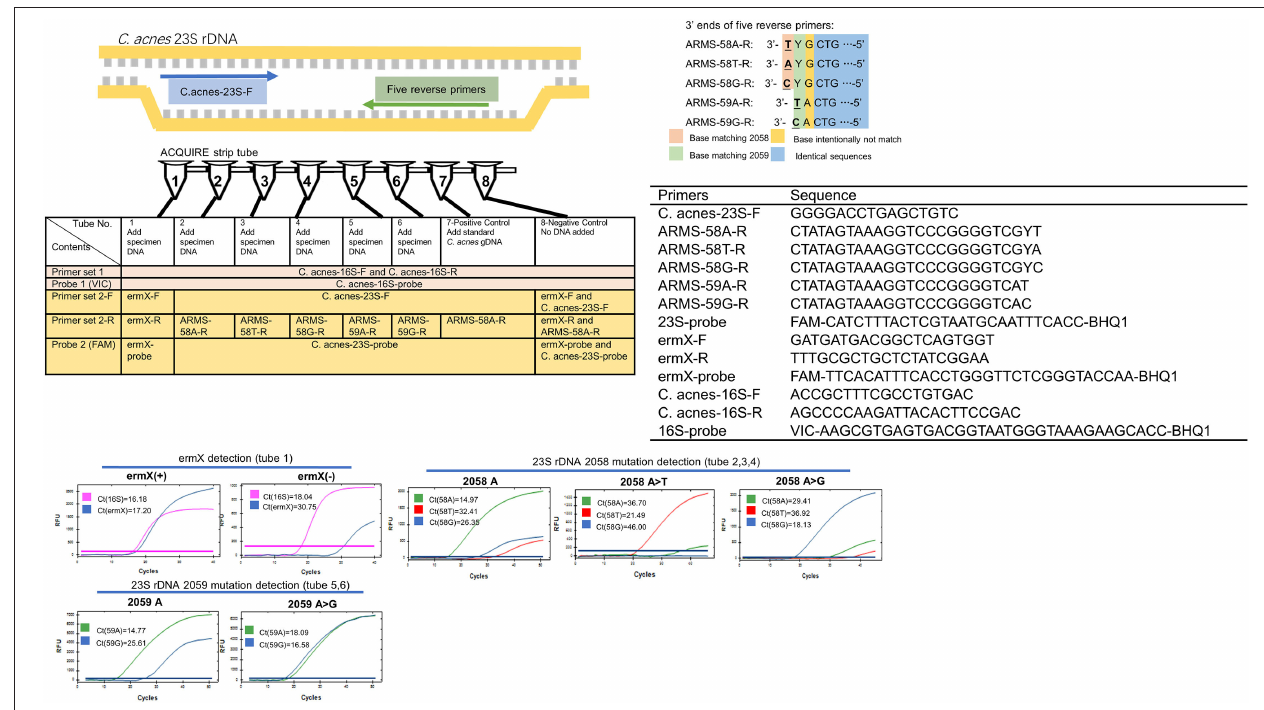
FIGURE 2 | Working principle, composition, and typical results of ACQUIRE. Composed of 10 PCR primers and three fluorescence probes, ACQUIRE is integrated into one 8-strip tube. Tube 1 interrogates ermX presence, tubes 2, 3, and 4 discriminate 2,058 A > T and 2,058 A > G from 2,058A. Tubes 5 and 6 discriminate 2,059 A > G from 2,059A. Tube 7 and 8 serve as a positive and negative control, respectively. The discrimination of 23S rDNA mutations was achieved by the Ct value difference caused by the match or mismatch of 3’ ends of five reverse primers. Additional mutations (base intentionally not match) were introduced into primers to strengthen this